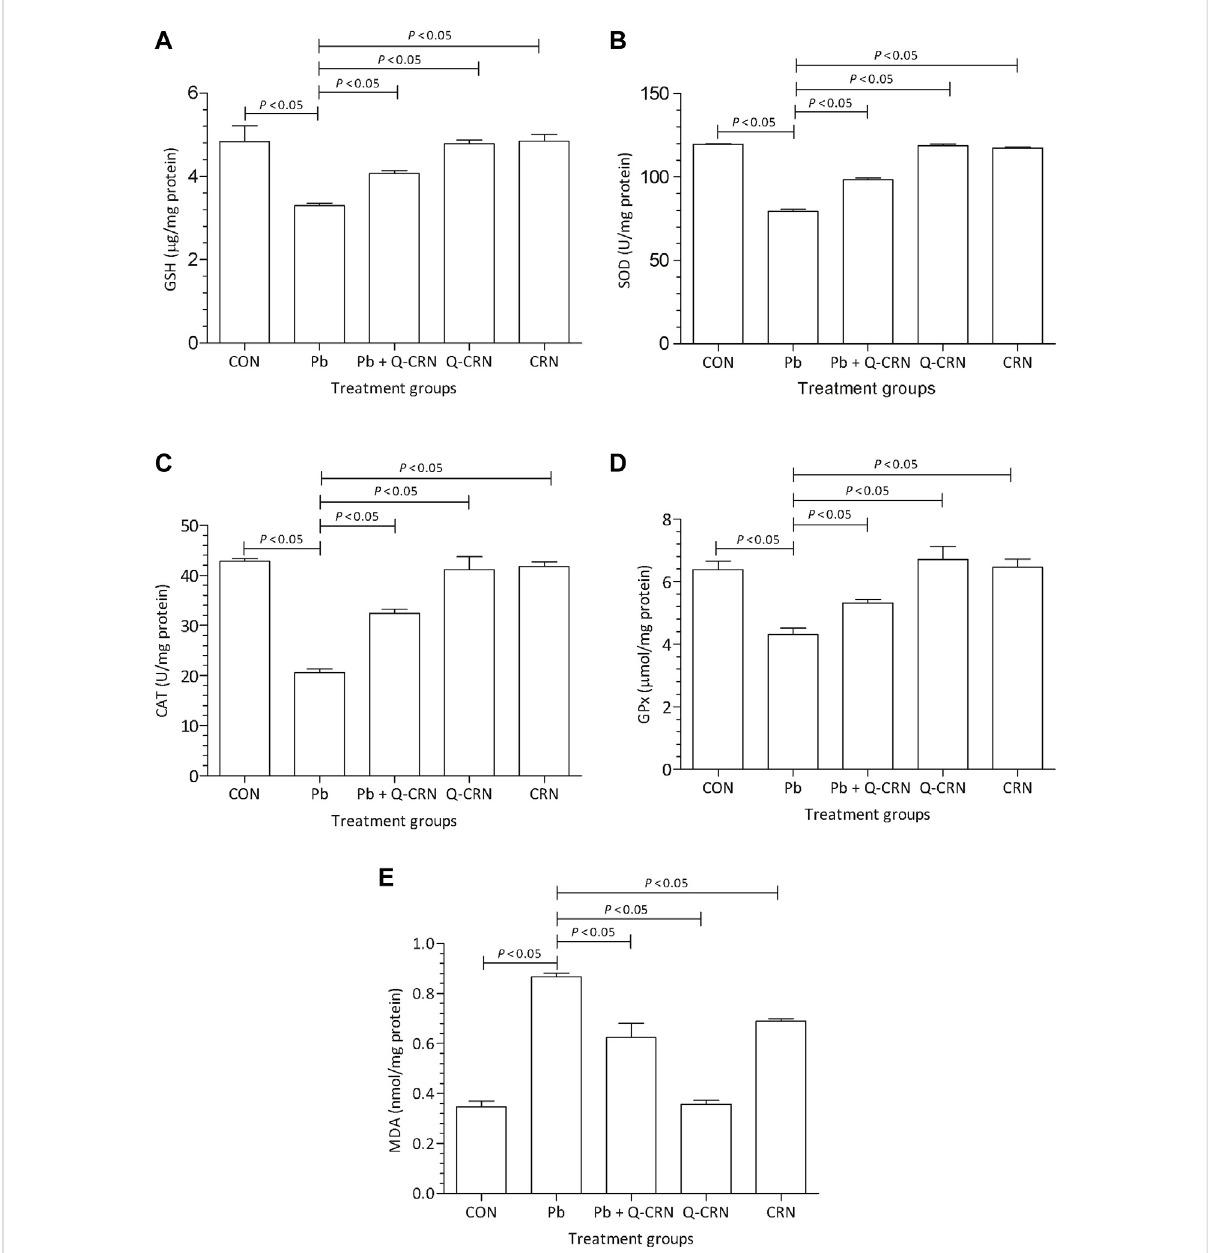
FIGURE 3 Effect of intoxication of Pb on the liver (A) GSH, (B) SOD, (C) CAT, (D) GPx, and (E) MDA and the ameliorative effect of Que. The levels of GSH, SOD,CAT,GPx,andMDAweremeasuredattheendoftheexperimentinthehepatictissuehomogenate.Thelevelofsigni fi cancewassetat p <